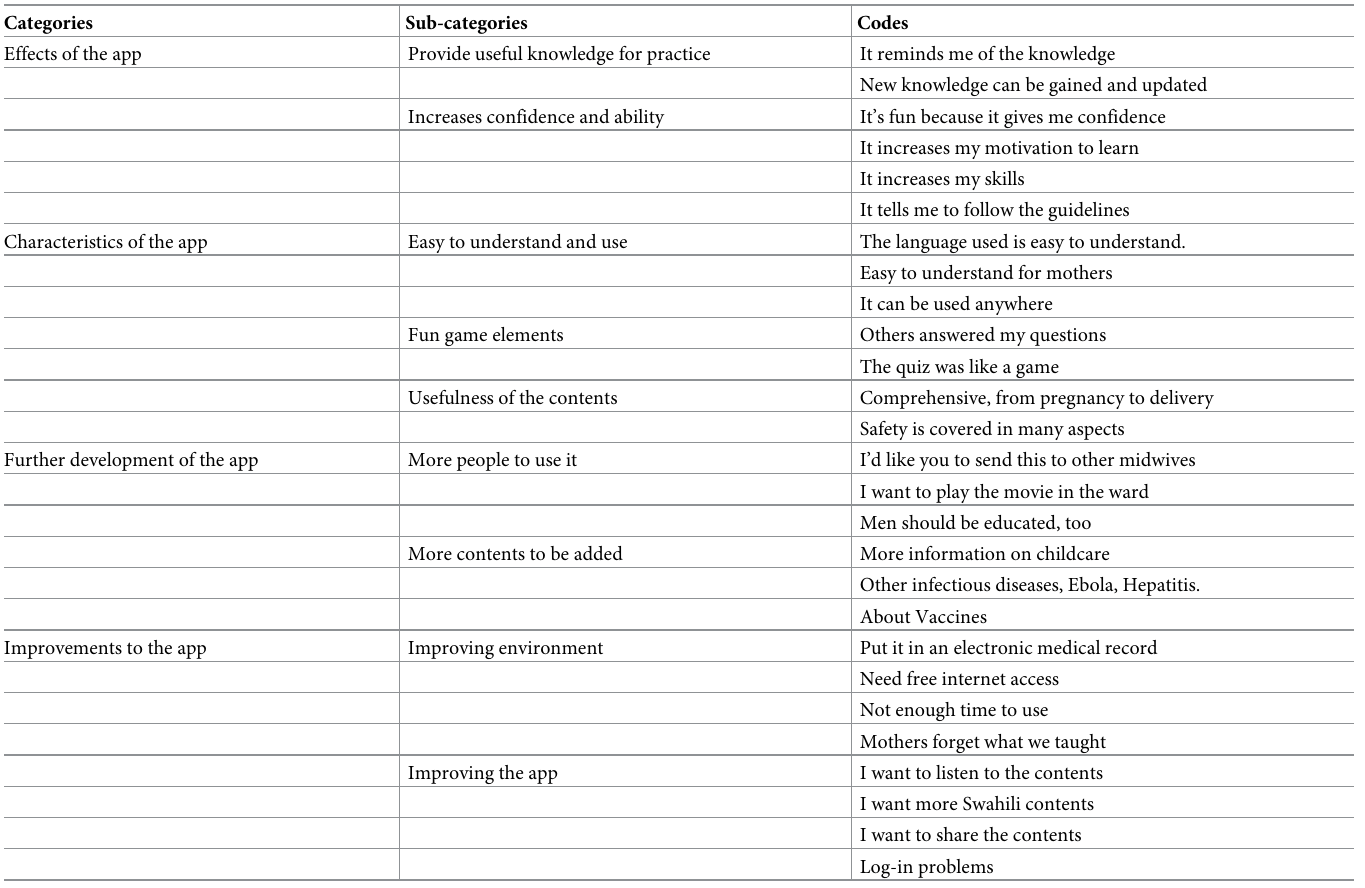
Table 2. Categories and sub-categories emerged from the focus group